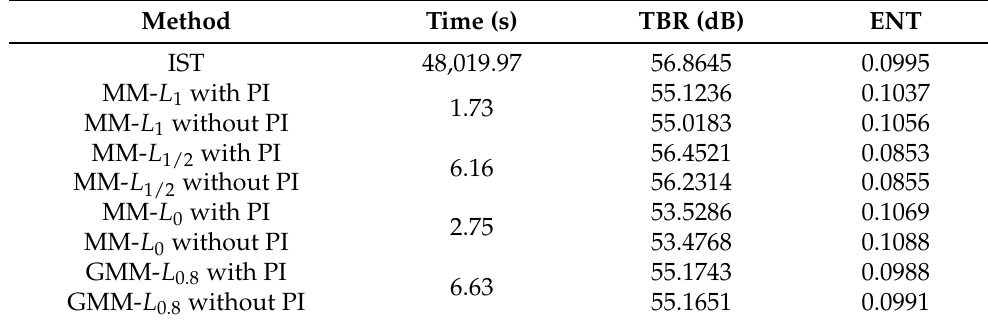
Table 9. The Time, TBR and ENT of the Aircraft.